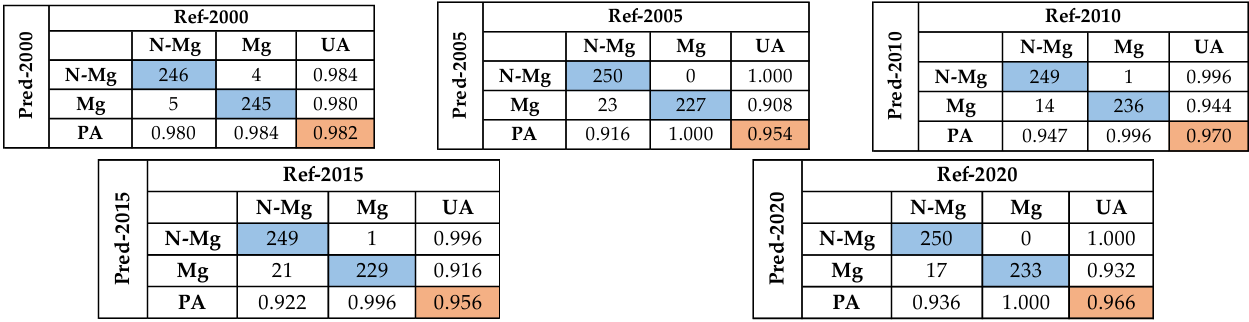
Figure 6. Confusion matrix result from independent reference testing points in 2000, 2005, 2010, 2015 and 2020. N-Mg, Mg, UA, and PA stand for non-mangrove class, mangrove class, user’s accuracy, and producer’s accuracy, respectively. The blue color in the confusion matrix tables is true positive and true negative, while the orange box is overall accuracy.